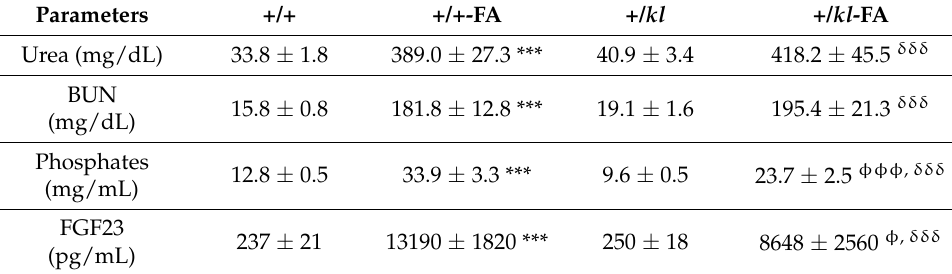
Table 2. Biochemical plasma parameters in +/+ and +/kl mice after AKI.